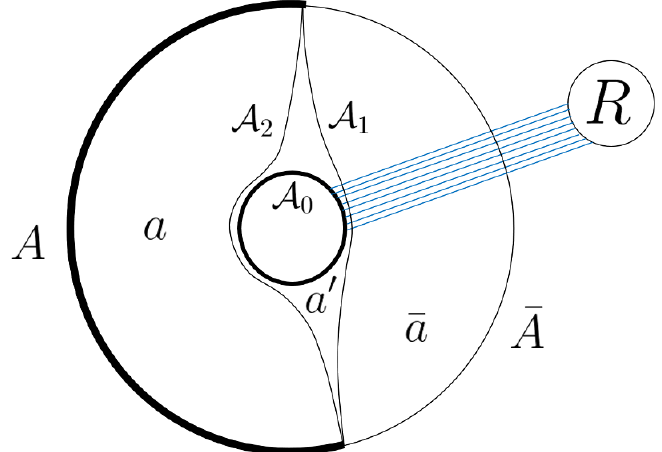
Figure 5 . The black hole is now entangled with a reference system R . If the entanglement between the black hole and R has entropy greater than A 2 (cid:0)A 1 , the entanglement wedge of (cid:22) A [ R is (cid:22) a [ a 0 [ R . 4 G N Otherwise the entanglement wedge of (cid:22) A [ R is only (cid:22) a [ R . In other words A contains the (cid:11) -bits of region a 0 for the entire code space H . This code region contains not just the black hole, but also an additional bulk region outside the black hole horizon but between the two minimal surfaces. In contrast the region a can be decoded for the entire code space, since this region will always lie outside the entanglement wedge of region (cid:22) A [ R